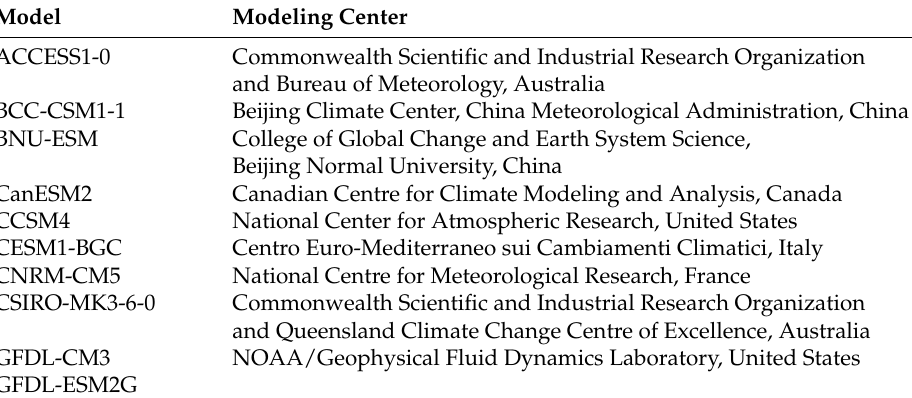
Table 1. CMIP5 General Circulation Models (GCMs) used to generate the NASA Earth Exchange Global Daily Downscaled Projections (NEX-GDDP) dataset.